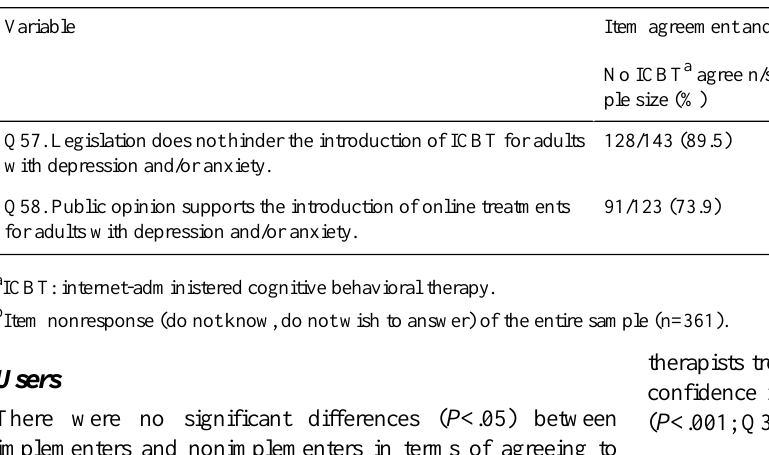
Table 6. Implementers and nonimplementers agreeing to society-related items.